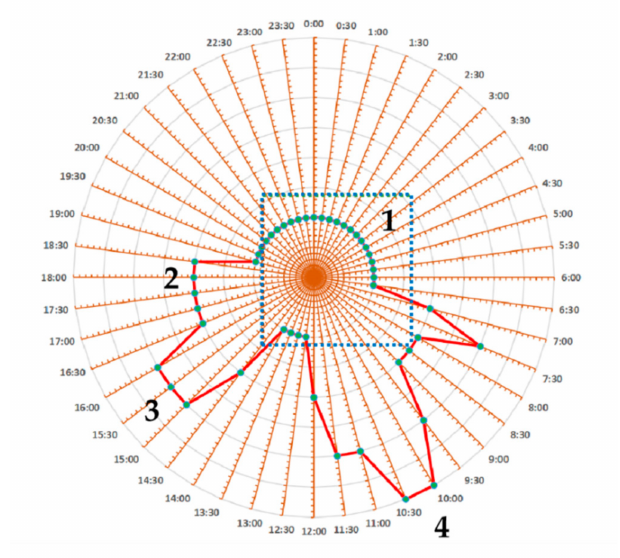
Figure 14. The proportion time of different sow behaviors in 24 h (1, lying down; 2, standing sows in the active area; 3, standing sows in the feeding and drinking area, and drinking water; 4 the sow being eats in the drinking and feeding area).